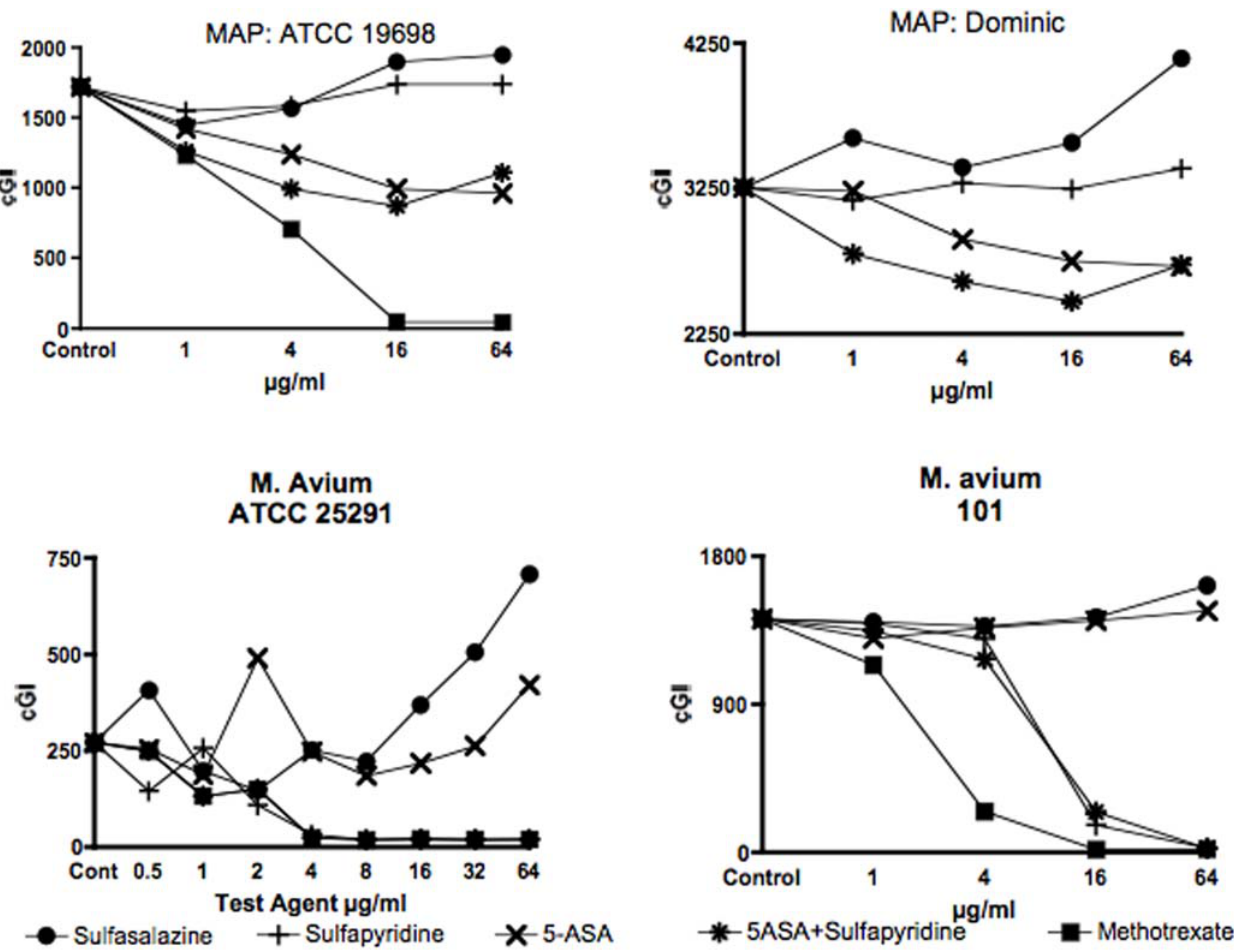
Figure 2. A composite graph of the two MAP and two M. avium bacterial strains studied. Each dose was studied in singlicate. For MAP ATCC 19698, 6 6 10 4 CFU’s wereinoculated/vial. Sulfasalazine isthe negativecontrol for bothMAP and M. avium strains. In all strains there is dose dependent increase in cGI. There is no inhibition by sulfapyridine alone with either MAP strain. 5-ASA has dose dependent inhibition on both MAP strains. Note the subtle synergy up to 16 m g/ml for both MAP strains for the 5-ASA + sulfapyridine group compared to 5-ASA alone. The positive control in the Dominic study was clarithromycin which, because it was diluted in methanol, is off scale. Accordingly, the clarithromycin data are not presented.